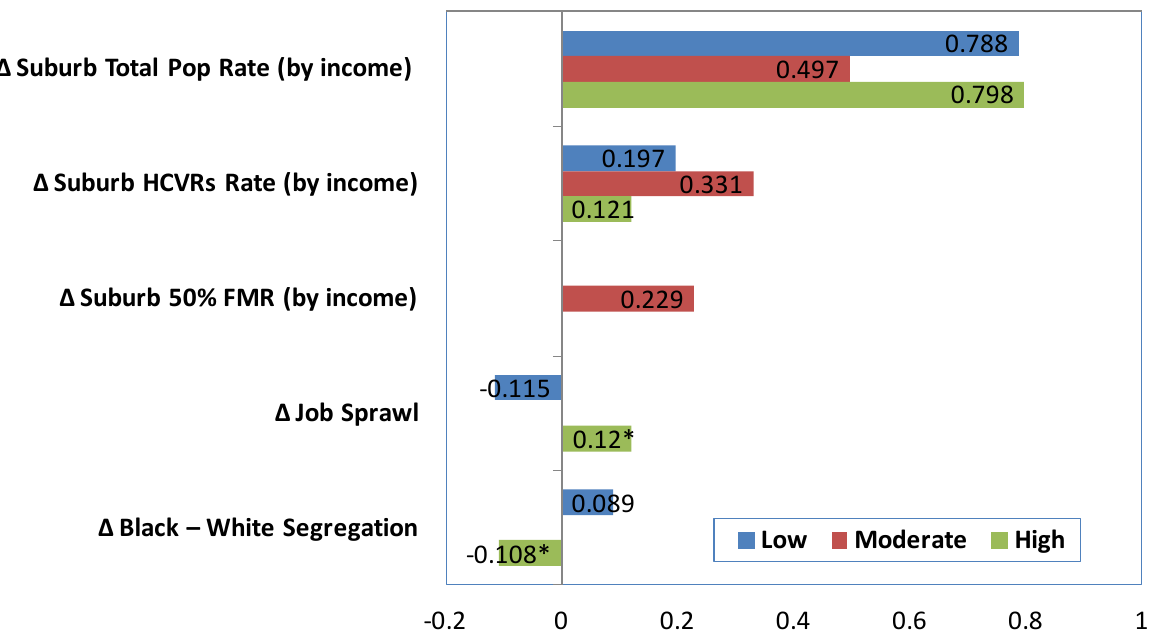
Figure 4. Key features within suburbs associated with poverty suburbanization, 2000–2008. Source: author’s analy- sis of HUD data, Census 2000 and ACS five-year estimates 2005–2009. Significant Standardized coefficients (not displayed in tables above) are presented for the weighted change regressions. * Unweighted